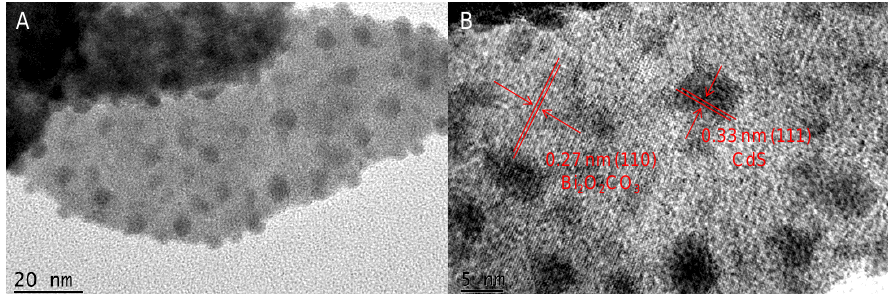
Figure 3. TEM images of the prepared Bi 2 O 2 CO 3 /CdS QDs-10 photocatalyst: low magnification ( A ) and high magnification ( B ).